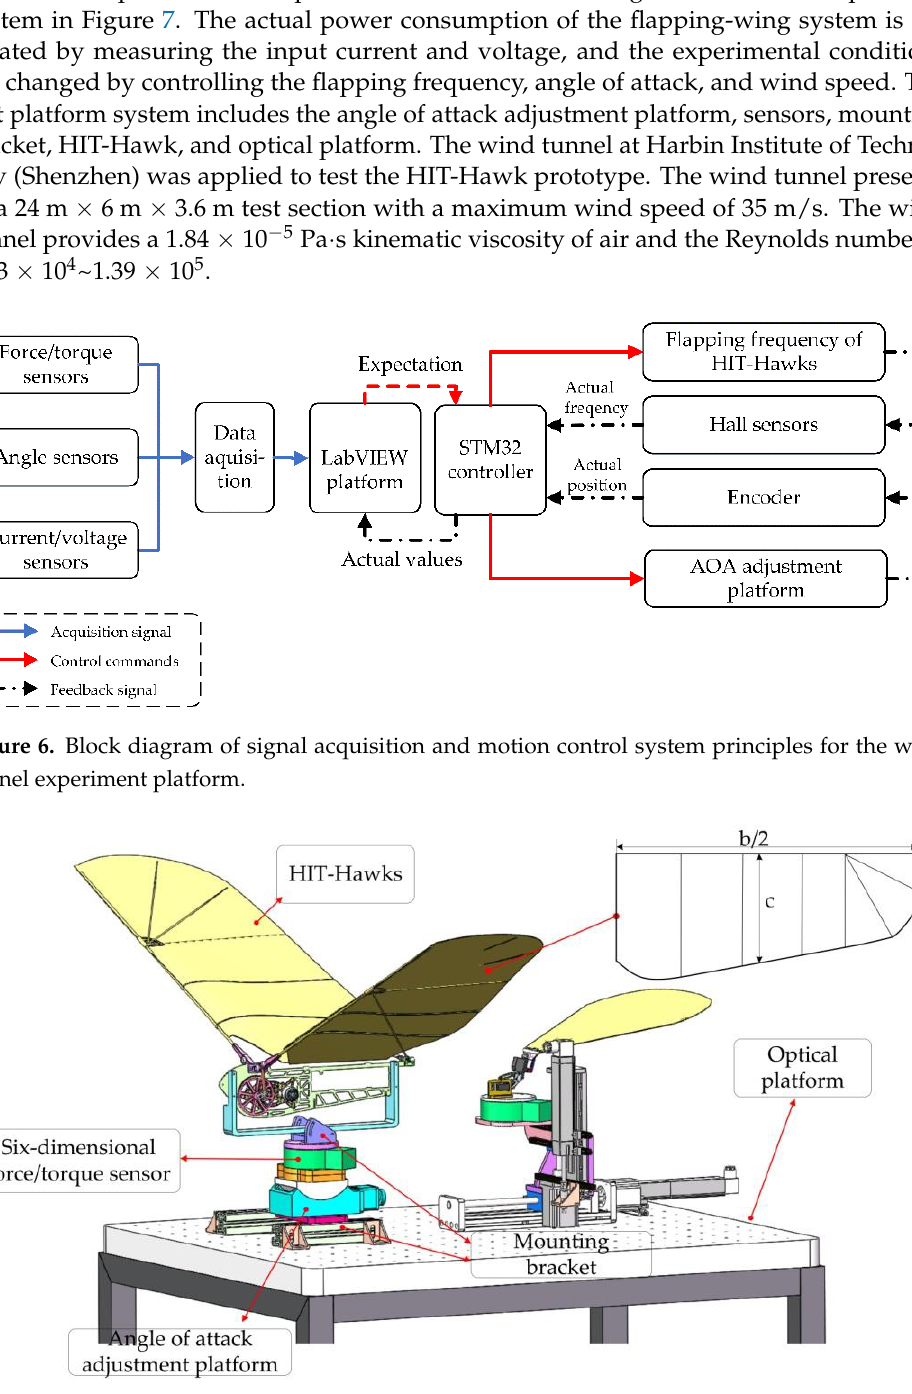
Figure 7. Diagram of the installation of the wind tunnel test platform.